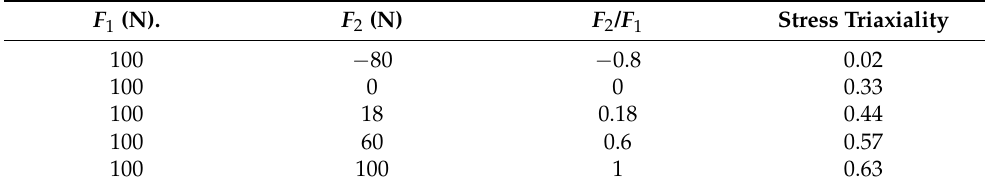
Figure 16. Boundary conditions for RVE simulations (the left edge and bottom edge were both fixed in the X- and Y-direction, and the uniform loads F 1 and F 2 were applied on the right and at the top which F 1 was fixed and F 2 was varied). Table 9. The values of applied uniform loads F 1 and F 2 for different stress triaxialities. (N). F 1